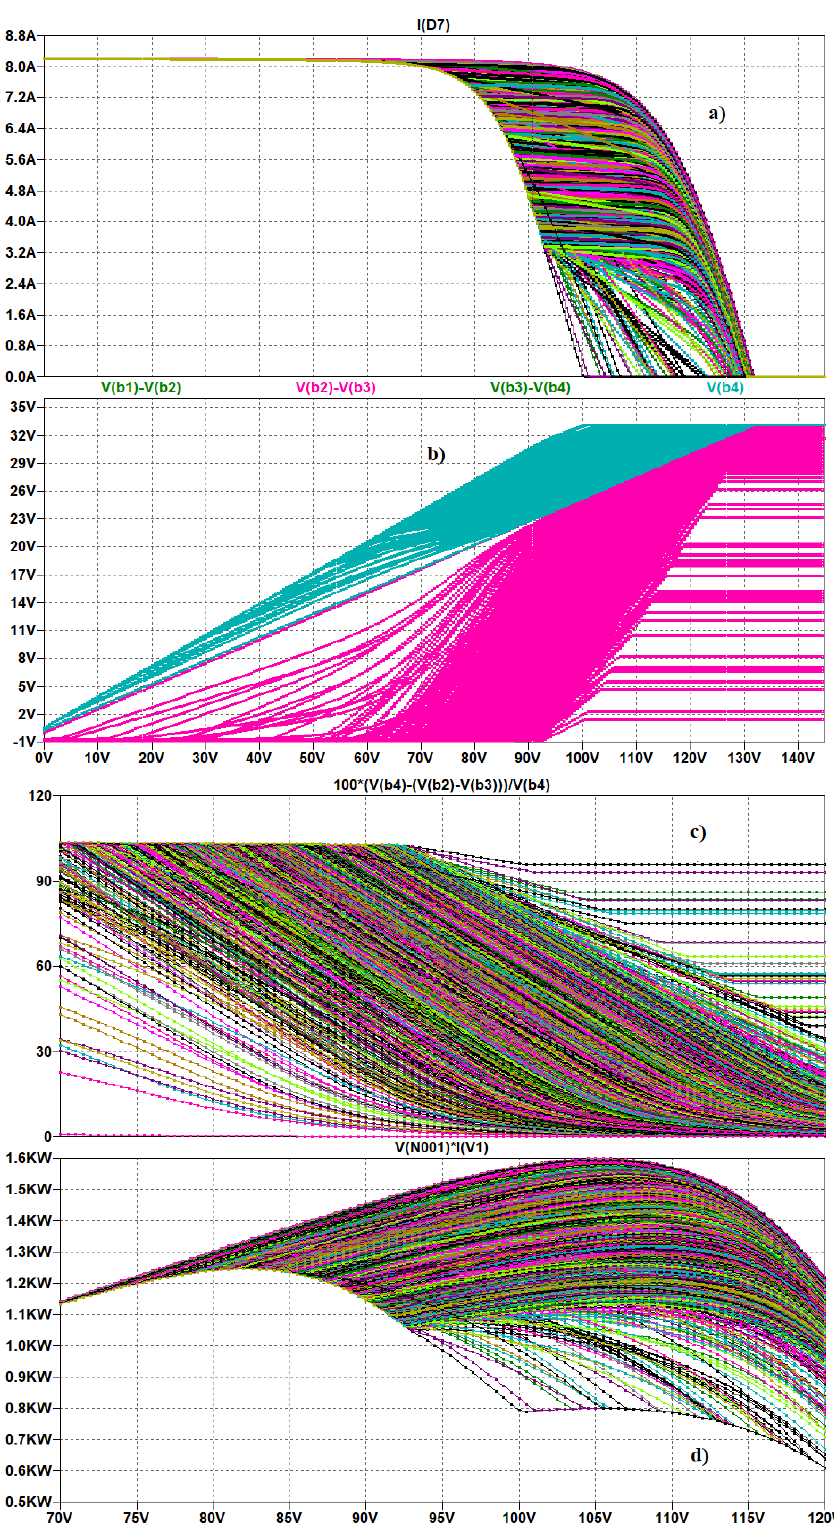
Figure A2. Optical heterogeneous degradation faults. This figure shows four charts as following: ( a ) the current of the affected string versus the operation voltage of the array, ( b ) the differential voltage for all the modules in the affected string, ( c ) the relative percentage difference versus the operating voltage of the array, ( d ) peak behavior of output power in the